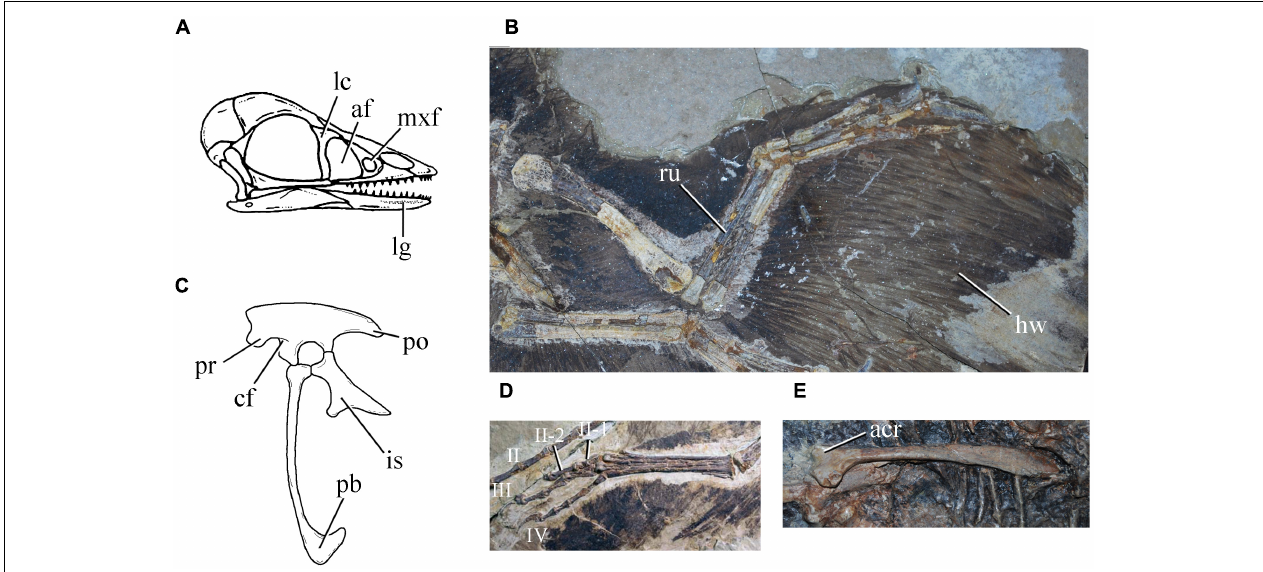
FIGURE 6 | Selected anchiornithine traits: (A) reconstruction of Anchiornis huxleyi (modified from Agnolin and Novas, 2013) skull, showing nutrient foramina on dentary placed in a deep groove, small anterior dentary teeth, maxillary fenestra ventrally placed, and antorbital fenestra dorsoventrally expanded; (B) Anchiornis huxleyi left forelimb showing straight radius and ulna and long covert feathers; (C) reconstruction of Anchiornis huxleyi pelvic girdle showing anteriorly long postacetabular blade and ventrally oriented preacetabular blade (modified from Xu et al., 2011); (D) right foot of Anchiornis huxleyi (BMNHC PH 828); (E) Xiaotingia zhengi (STM 27-2) left scapula. acr, acromion; af, antorbital fenestra; cf, cuppedicus fossa; hw, wing feathers; is, ischium; mxf, maxillary fenestra; lc, lacrimal; lg, lateral groove of dentary; pb, pubic boot; po, postacetabular blade; pr, preacetabular blade; ru, radius. Not to scale.